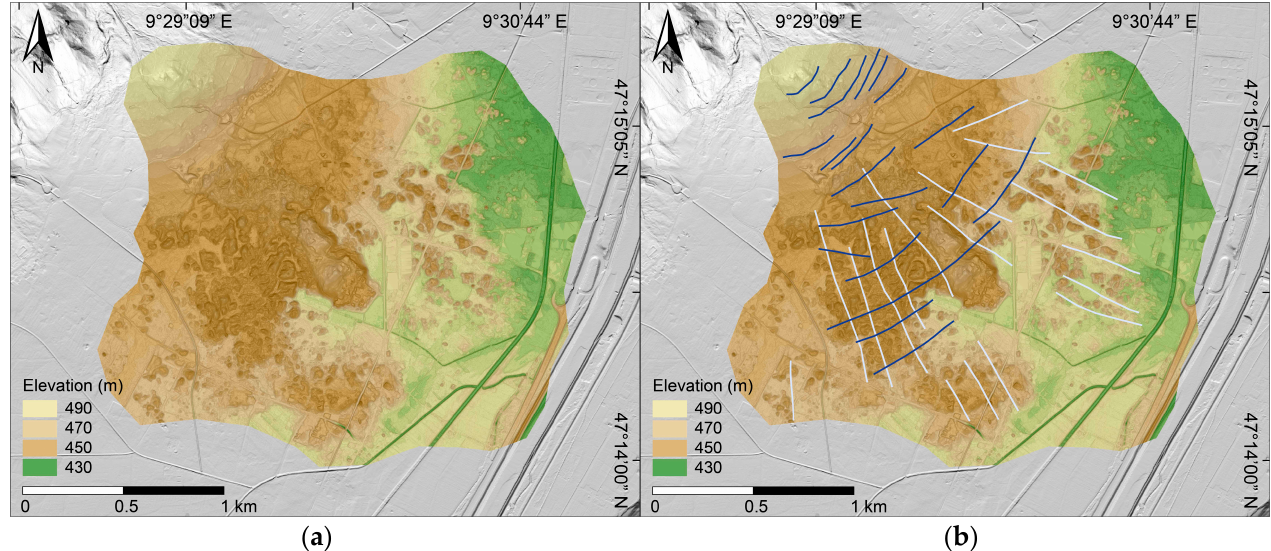
Figure 3. ( a ) Deposition area of the Sennwald landslide (green-brown) shown in detail on a shaded black and white relief image of Sennwald. ( b ) Transverse (blue lines) and linear (white lines) ridges indicate flow patterns. Shaded relief image superimposed by a color-coded DEM 15 (swissALTI3D) reproduced with the authorisation of swisstopo (JA100120).